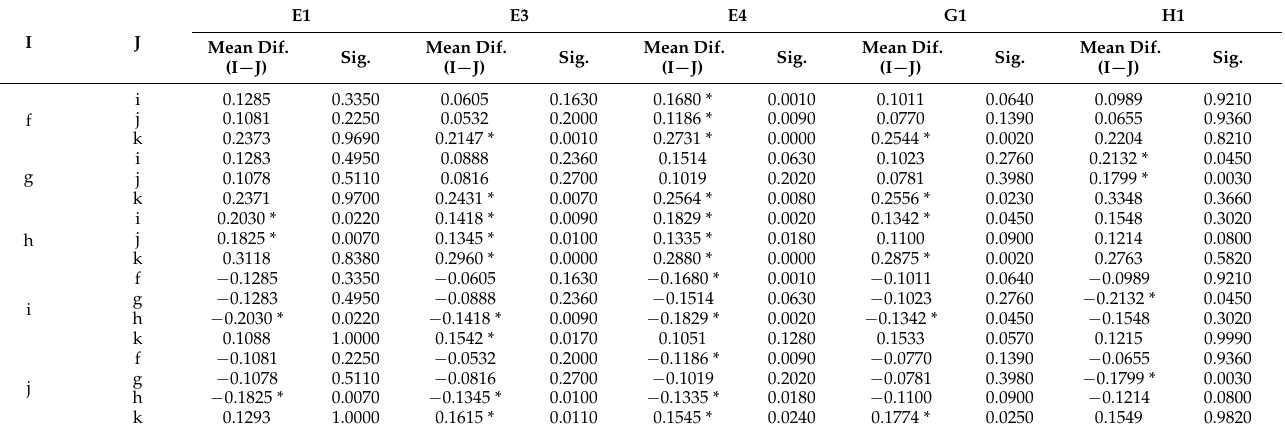
Table 6. Multiple comparison analysis of sensory perception indicators of riverside parks of different types (only some important data are displayed here; all data can be found in the Supplementary File in the Supplementary